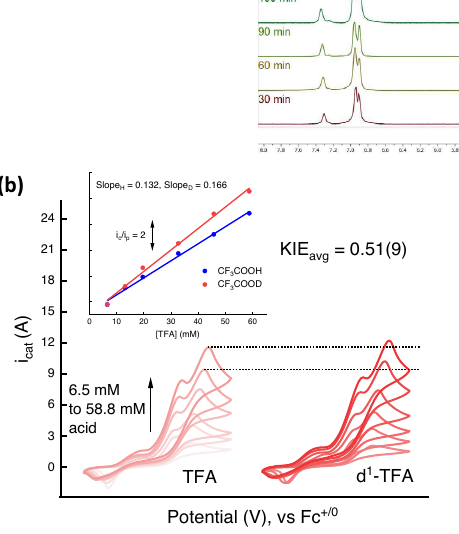
concentrations. The normalized currents ( i c / i p ) were plotted for CF 3 COOH and CF 3 COOD versus acid concentrations and the KIE was obtained as explained in the Supporting Information. c The likely source of inverse KIE in HER catalysis is the cleavageof the Ni – C bond to formC – H(D)bond due to a proton-coupled electron transferstep.ThesebondsarehighlightedinbluefortheNi – Hspeciesandpinkfor the Ni – D species,